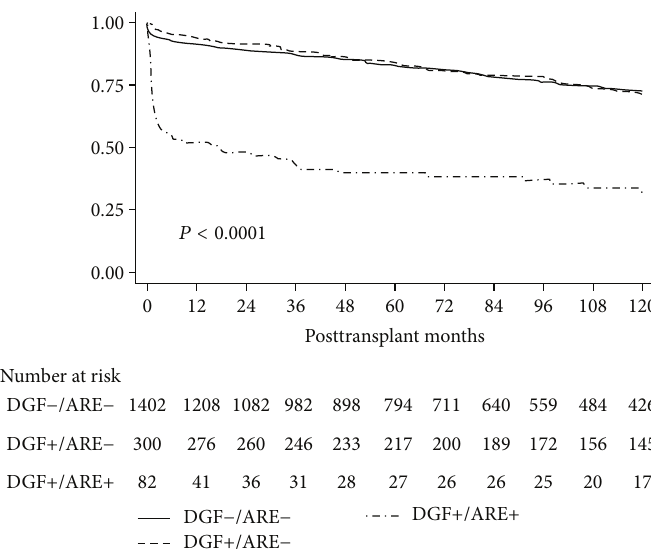
Figure 2: Deceased censored graft survival according to presence (+) or absence (−) of delayed graft function (DGF) and acute rejection episodes (ARE) in 1784 grafts performed from 1983 to